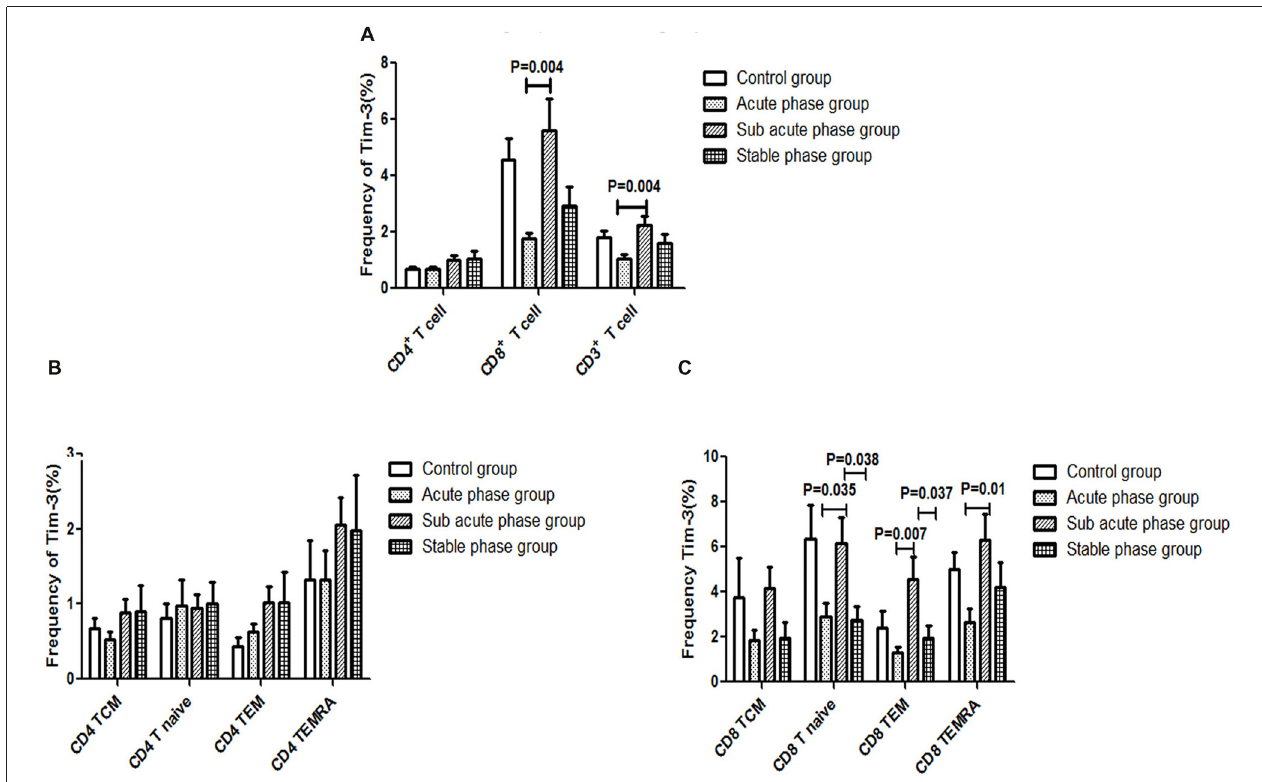
FIGURE 7 | (A) T cell immunoglobulin and mucin domain 3 (Tim-3) expression in T cells in the IS groups and the control group. (B) Tim-3 expression in CD4 + T cells in the IS groups and the control group. (C) Tim-3 in expression CD8 + T cells in the IS groups and the control group (comparisons between groups were